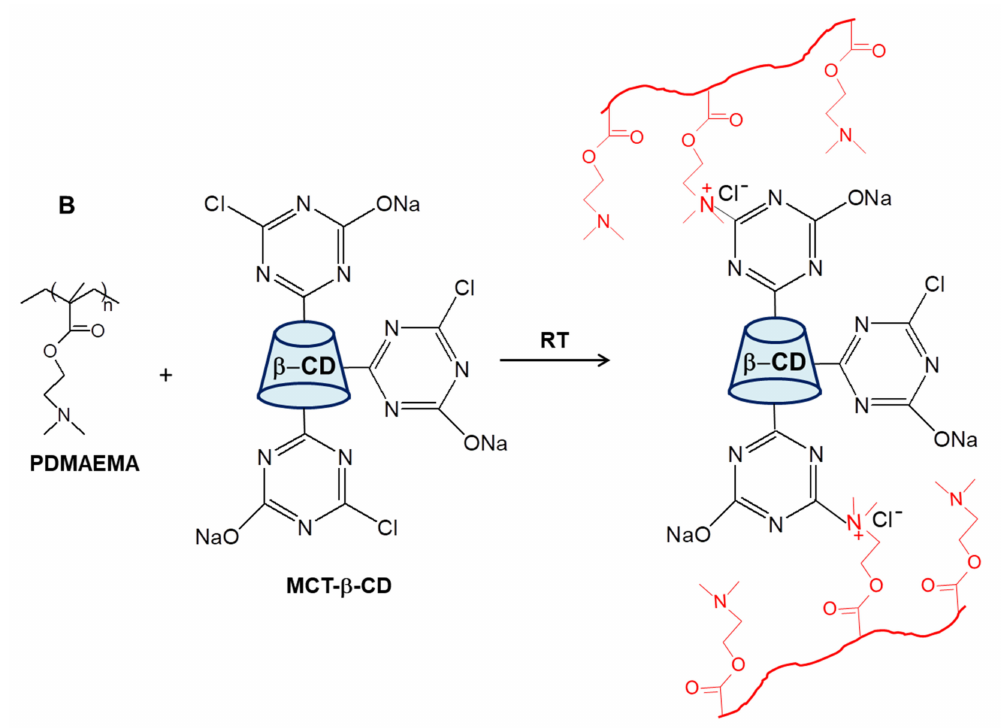
Figure 2. Schematic representation of the synthesis of semi-IPN and IPN cryogels ( A ); cross-linking reaction of PDMAEMA with MCT- β -CD ( B ).